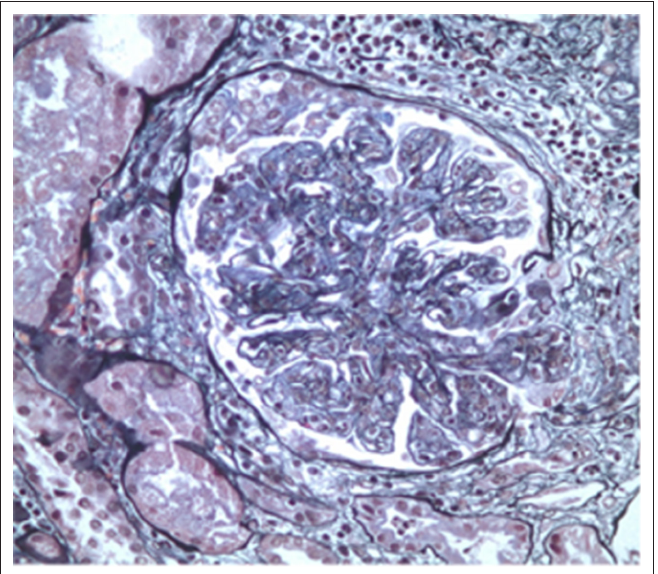
Figure 2. Silver stain emphasizing diffuse endocapillary and segmental extracapillary